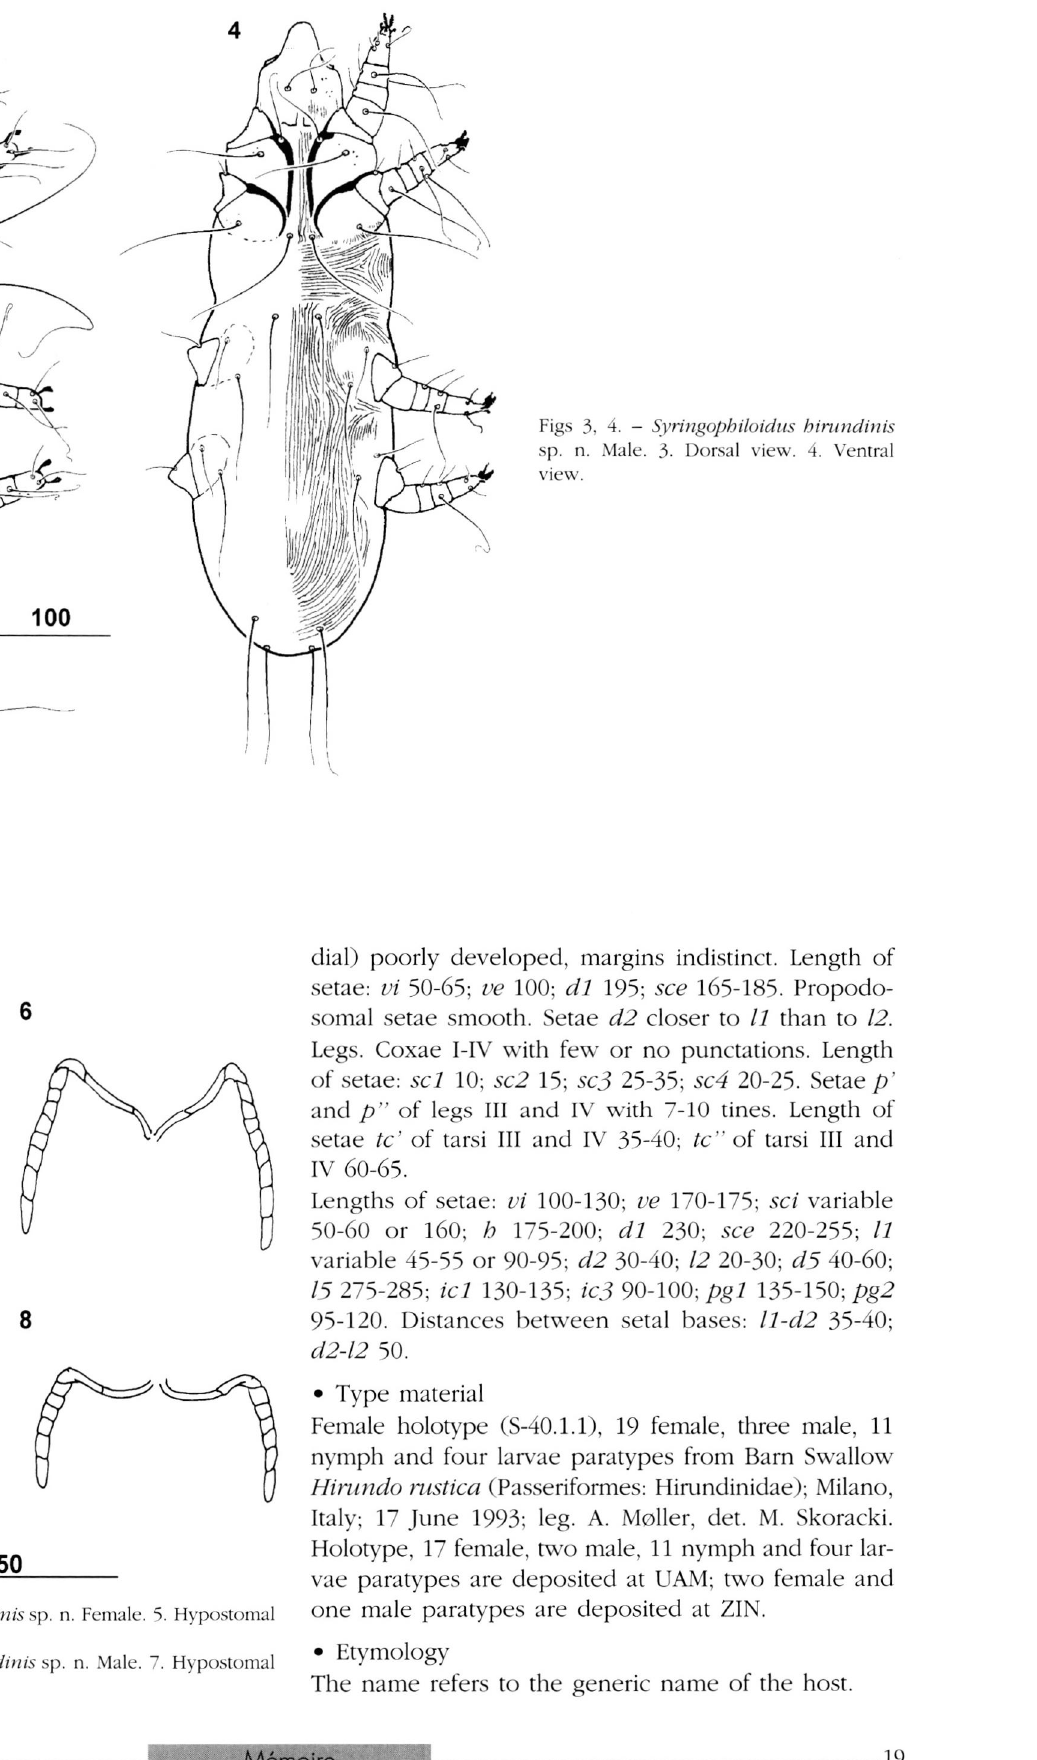
Figs 3, 4. - Syringopbiloidns